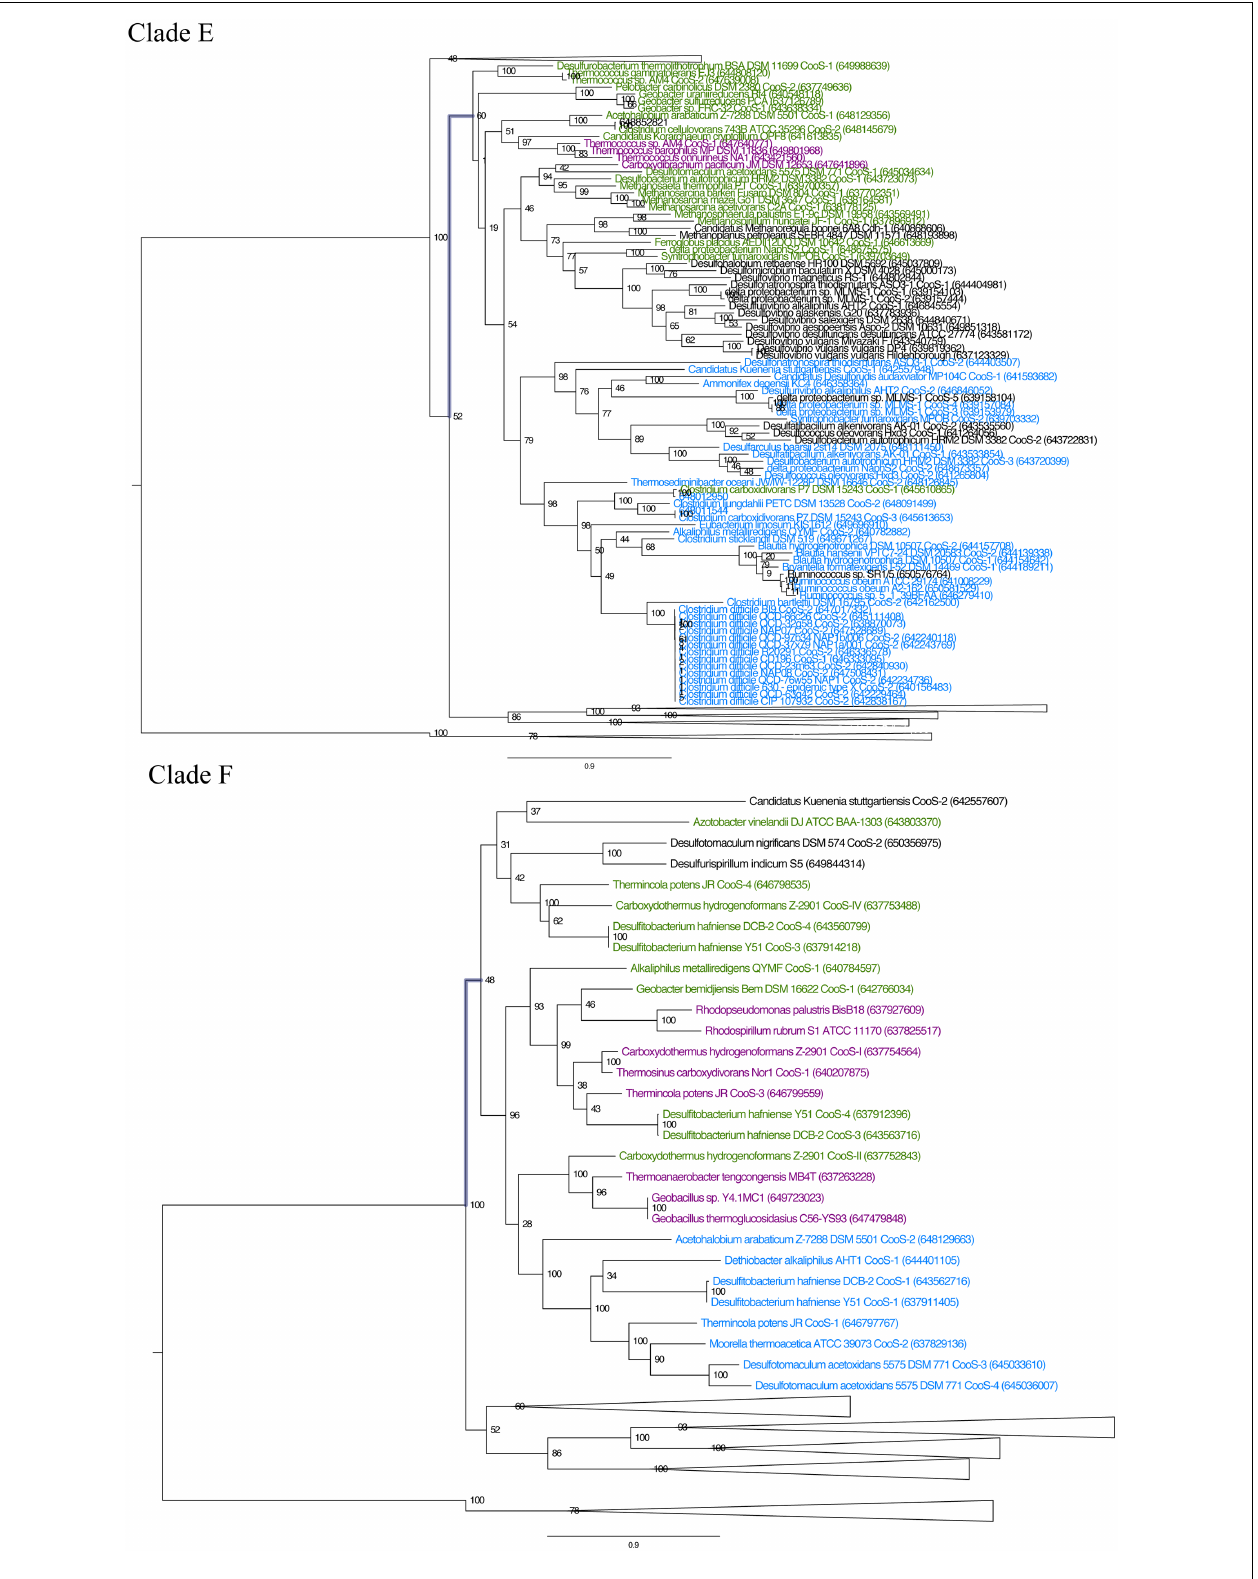
FIGUREA2 | Subtrees of maximum likelihood tree of [Ni,Fe]-CODHs (Figure 2) divided based on clades.